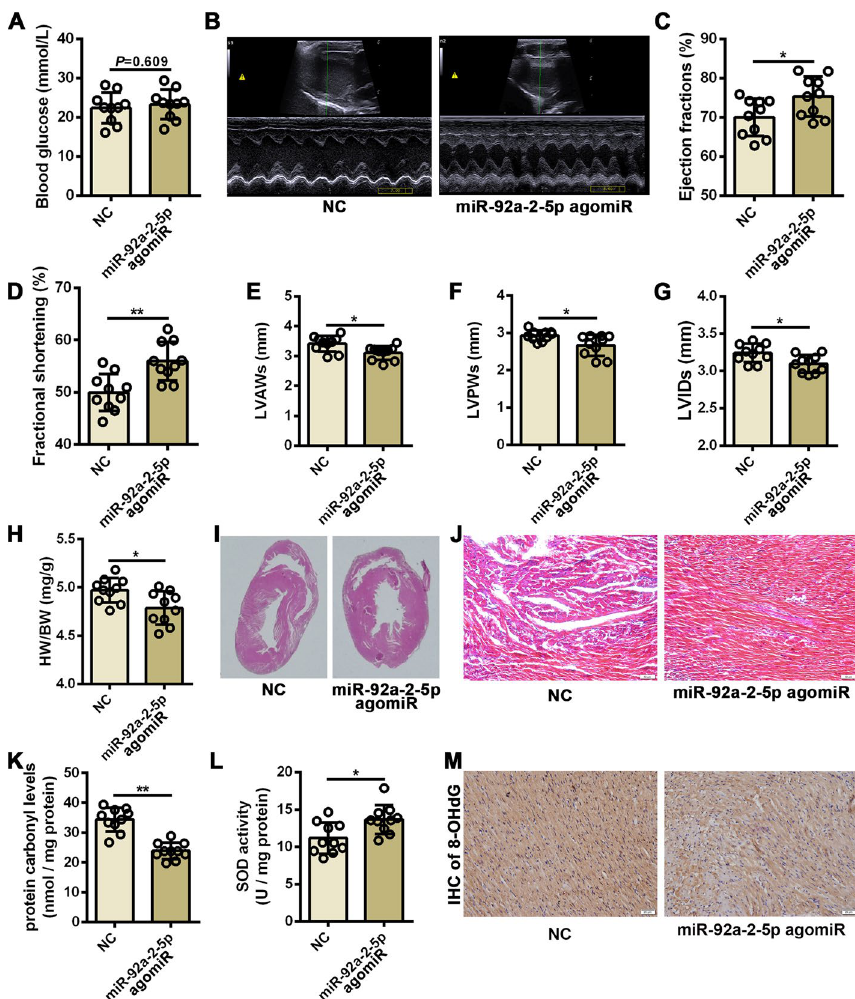
Fig. 6 Administration of miR-92a-2-5p improved cardiac remodeling and function in diabetic rats. A Detection of random blood glucose level in diabetic rats injected with the miR-92a-2-5p agomiR. n 10 in = each group. B Representative echocardiographic images of the diabetic rat hearts from NC and miR-92a-2-5p agomiR groups. C - G Evaluation of the mean values of EF, FS, LVAWs, LVPWs, and LVIDs in diabetic rats. n 10 = in each group. * P < 0.05, and ** P < 0.01. H Determination of heart weight/body weight (HW/BW) ratio in diabetic rats from the NC and miR-92a-2-5p agomiR groups. n 10 in each group. ** P < 0.01. I Representative = images of H & E staining of rat hearts from NC and miR-92a-2-5p agomiR groups. J Representative images of Masson’s staining in rat left ventricle tissues from the NC and miR-92a-2-5p agomiR groups. Scale bar 50 μm. K - L Detection of protein carbonyl levels and superoxide dismutase (SOD) activity in the heart = tissues from the NC and miR-92a-2-5p agomiR groups. n 10 in each group. * P < 0.05, and ** P < 0.01. M = Representative images of immunohistochemistry (IHC) for 8-OHdG in rat left ventricle tissues from the NC and miR-92a-2-5p agomiR groups. Scale bar 20 =